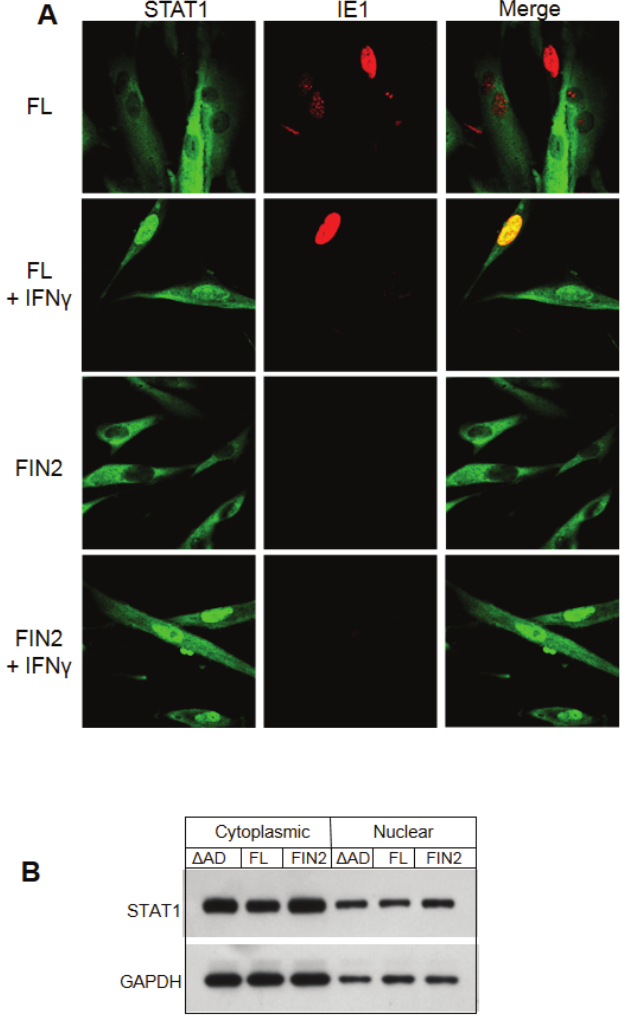
Figure 5. Nuclear translocation of STAT1 is not altered by IE1. ( A ) Immunofluorescence images of IE1 and STAT1 in cells with and without IFN γ treatment. MRC5 cells were nucleofected with the full length IE1 (FL) or empty vector (FIN2). After 24 hours cells were exposed to IFN γ for 30 minutes or left untreated. Cells were fixed in methanol and reacted with mouse monoclonal anti-IE1 antibody (Mab810) and rabbit polyclonal anti-STAT1 antibody followed by anti-mouse alexafluor 543 and anti-rabbit alexafluor 488 as secondary antibodies. STAT1 reactivity is visualized in green (left column), IE1 reactivity is visualized in red (middle column) and merged images are shown in the right column. ( B ) Film images of electrophoretically separated cell lysates reacted with antibodies to STAT1 and GAPDH (loading control). MRC5 cells were nucleofected with plasmid harboring full length IE1 (FL), the Δ 345–491 C-terminal truncation IE1 ( Δ AD) or empty vector (FIN2). At 72 hours after nucleofection, cells were exposed to IFN γ for 30 minutes or left untreated. Cells were harvested and nuclear and cytoplasmic fractions were separated. Equal amounts of protein from the nuclear and cytoplasmic lysates were subjected to electrophoresis in a denaturing polyacrylamide gel. Proteins were transferred to nitrocellulose sheets and reacted with the indicated